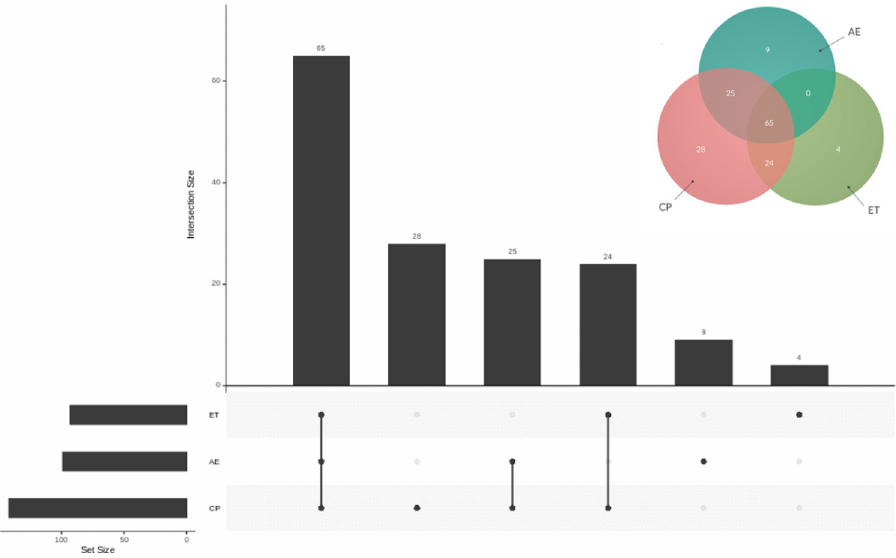
Fig 4. Venn diagram and UpSet plot of the Argentinian samples. Venn diagram and UpSet plot show the number of shared OTUs between chicken cecal Argentinian samples designated as ET: Experimental Trial, CP: Conventional Poultry, and AE: Agroecological